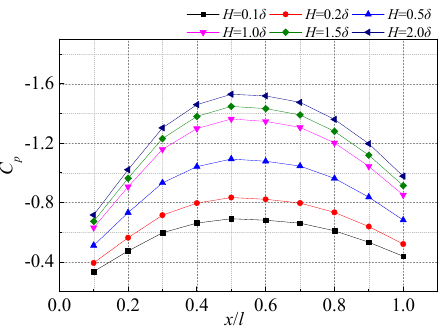
Figure 10. Distribution of static pressure coefficient at vortex core center.